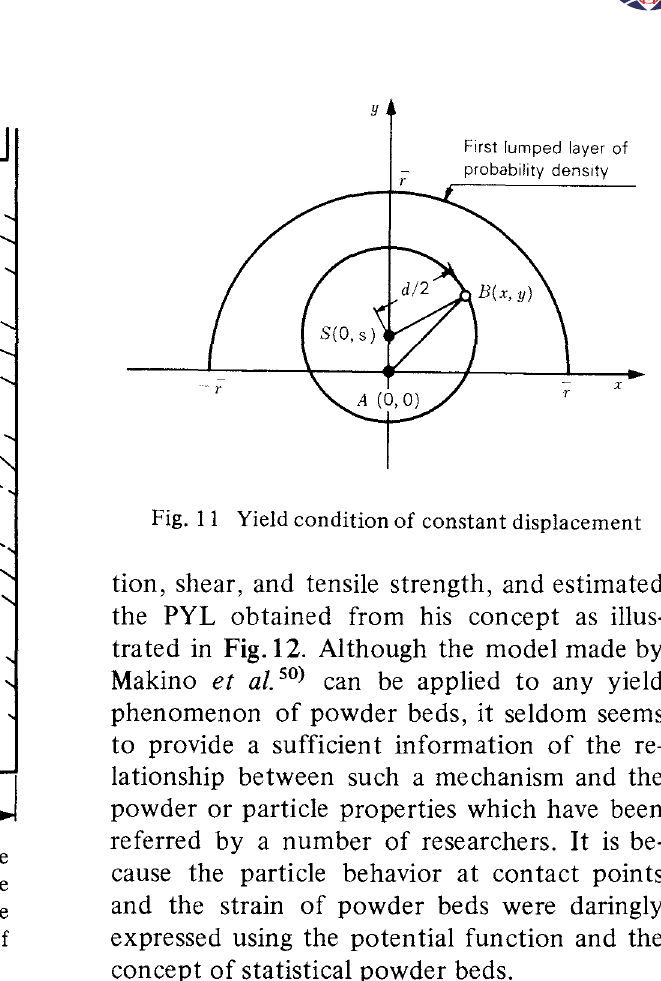
Fig. 10 Resultant stress distributions on the surface of the box (Silica sands are compressed under the mean pressure of 100kg/cm 2 on the lower surface of punch)